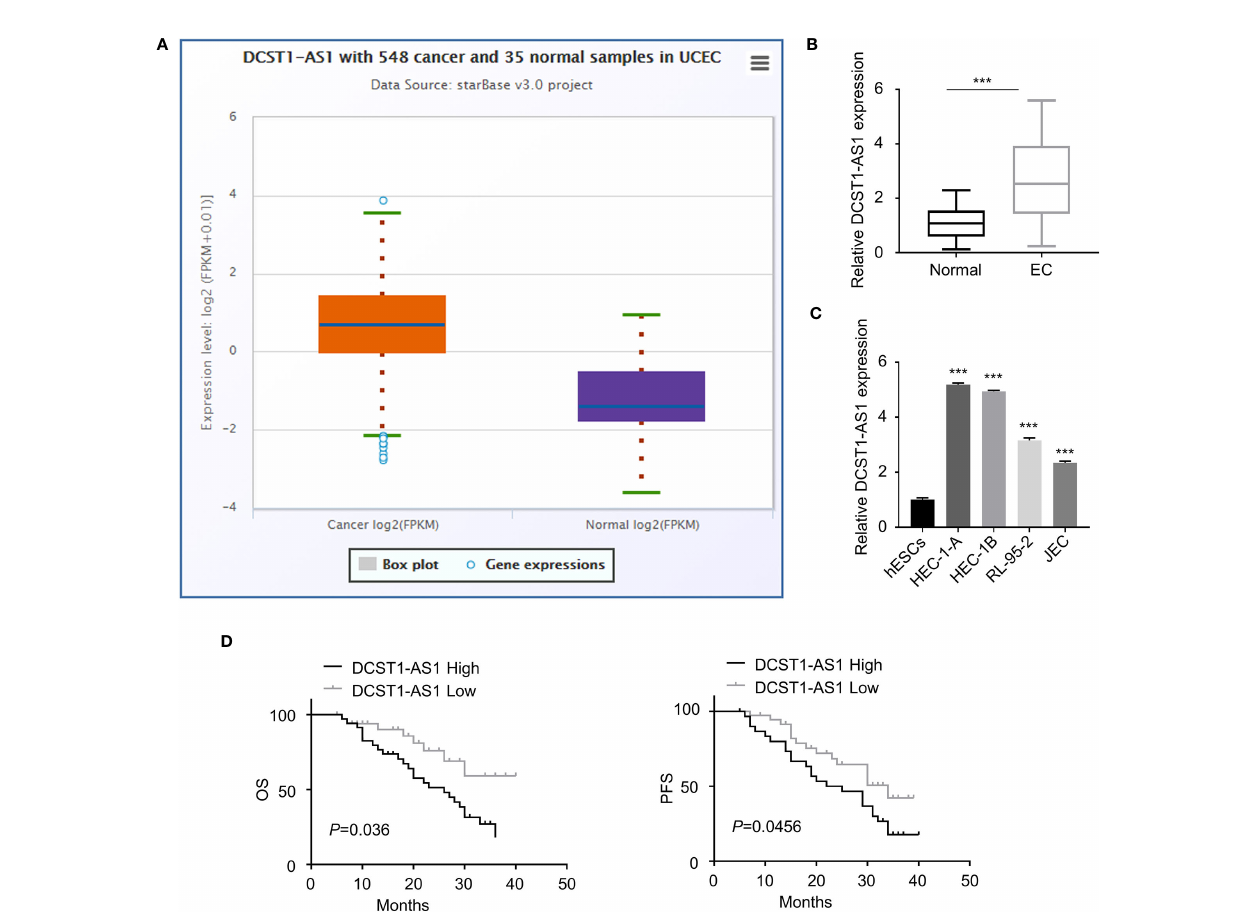
FIGURE 1 | LncRNA DC-STAMP domain-containing 1-antisense 1 (DCST1-AS1) expression is overexpressed in endometrial cancer (EC) tissues and cell lines. (A) The expression of lncRNA DCST1-AS1 in 548 EC tissues and 35 normal endometrium tissues (ENCORI database). (B) qRT-PCR analysis of DCST1-AS1 expression in 70 EC tissues and matched normal tissues. (C) Comparison of lncRNA DCST1-AS1 expression in the indicated EC cell lines and human normal endometrial stromal HESC cells using the qRT-PCR assay. (D) Kaplan – Meier curves for overall survival (OS) (left) and progression-free survival (PFS) (right) in EC patients with low or high DCST1-AS1 expression. *** P <